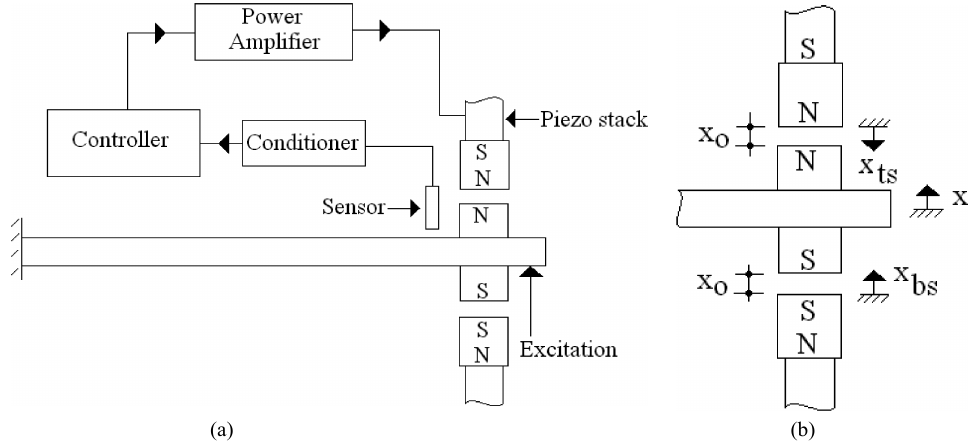
Fig. 1. (a). The arrangement of the beam along with twin actuators; (b). The gap and the displacements considered in the analysis.